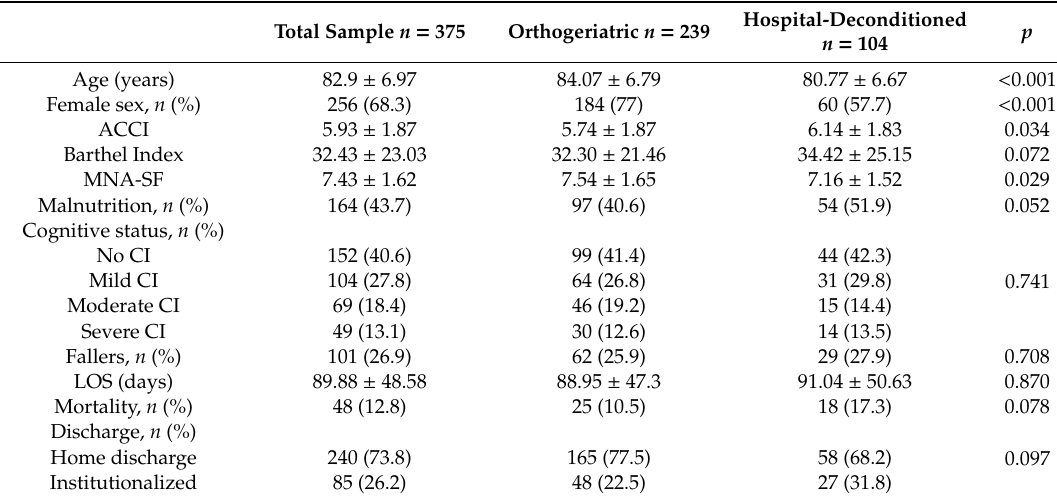
Table 2. Participant characteristics.